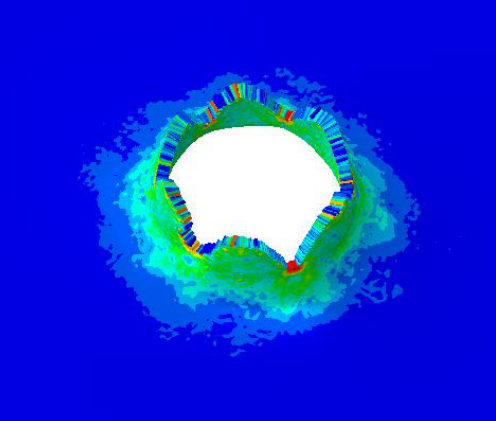
Figure 9. Details of target plate damage from a launch speed of 56 m/s.